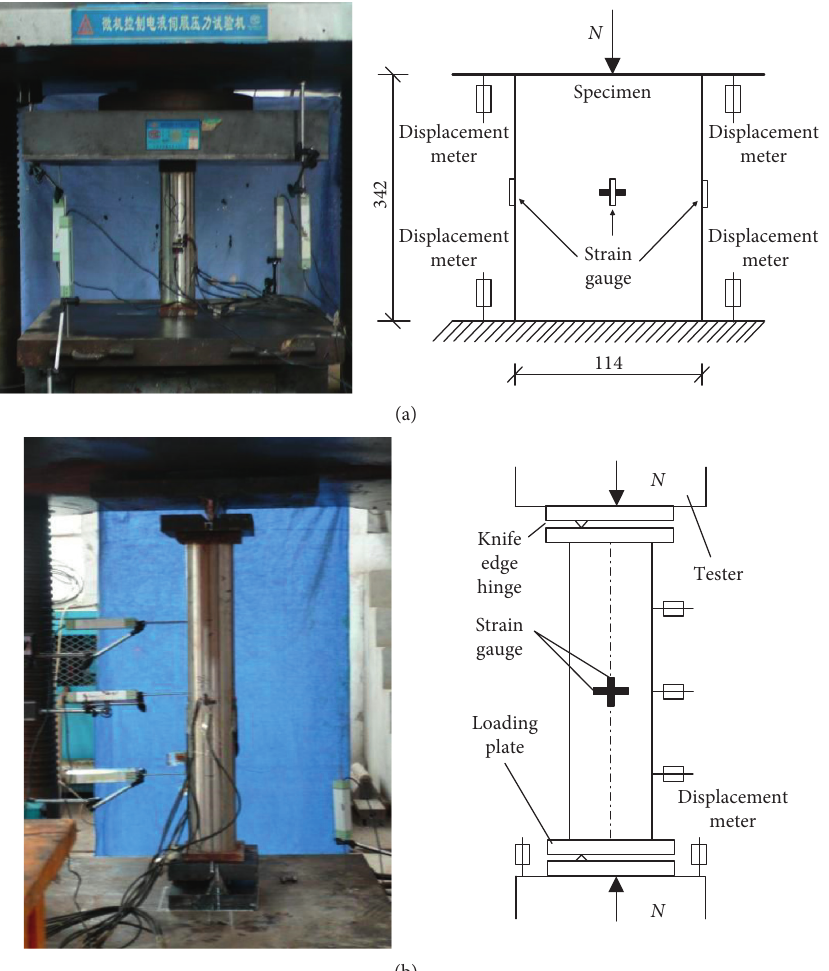
Figure 2: The loading device of (a) CFSSAST column under axial compression and (b) CFSSAST column under eccentric compression.